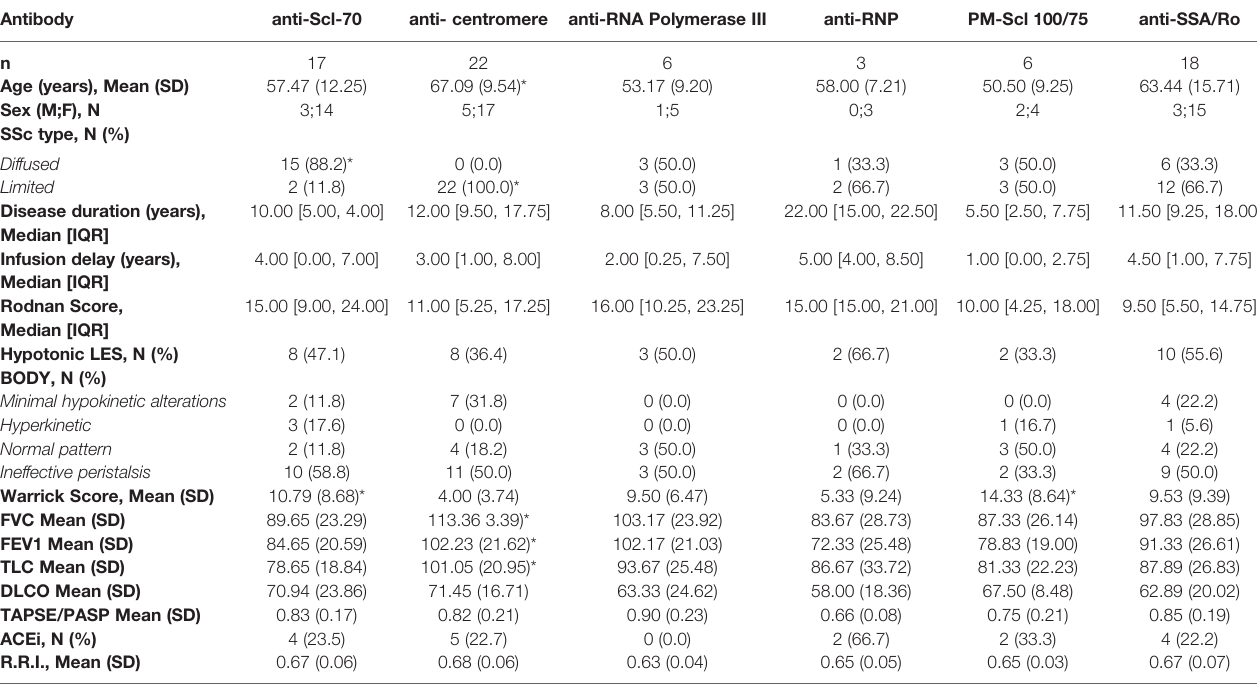
TABLE 3 | Overall characteristics, instrumental values and skin involvement based on the positivity of a speci fi c antibody